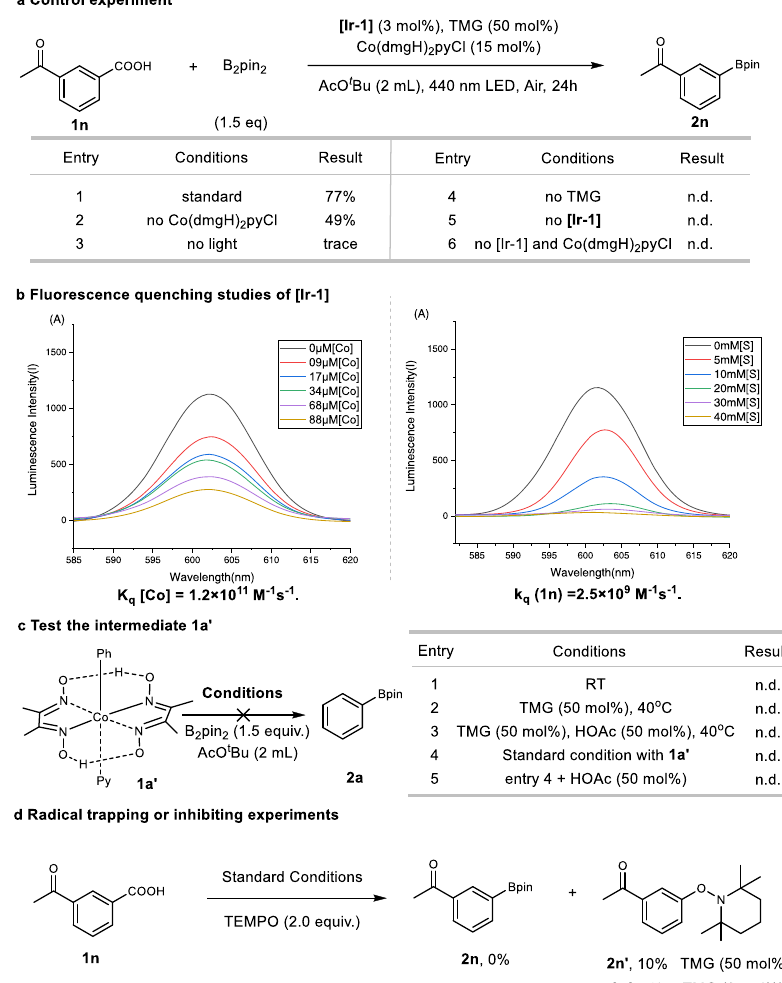
Fig. 3 | Control experiments for mechanistic investigation. For detailed condi- tions,seeSupplementaryInformationincludingacontrolexperimenttodetermine the key factors affecting the occurrence of reactions. [Ir-1] , [Ir(dF(CF 3 ppy) 2 )(5,5 ′ - CF 3 -bpy)]PF 6. AcO t Bu, tert- butyl acetyl ester. TMG, N, N ’ -Tetramethylguanidine. n.d., not detected. a Control experiments for mechanistic study. b Fluorescence quenching studies of photocatalysts Ir-1 (the varied colors lines represent